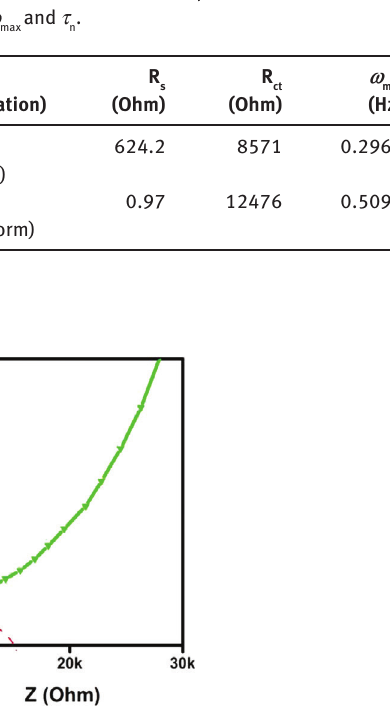
Figure 7: Semicircles of Nyquist plot for the films developed from (a) toluene and (b) chloroform under illumination.